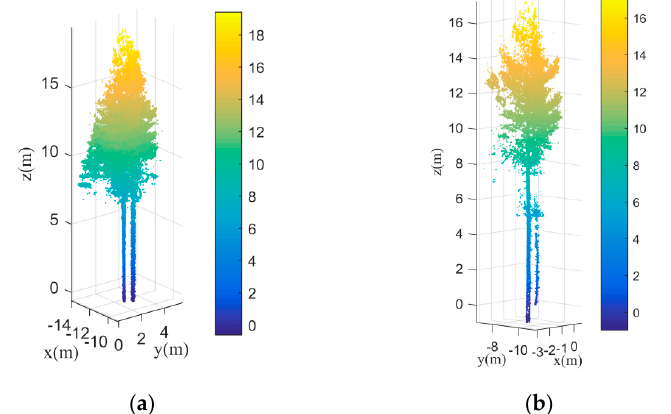
Figure 21. The wrongly separated individual trees and ( a , b ) are two examples of the smaller trees that cannot be detected accurately.